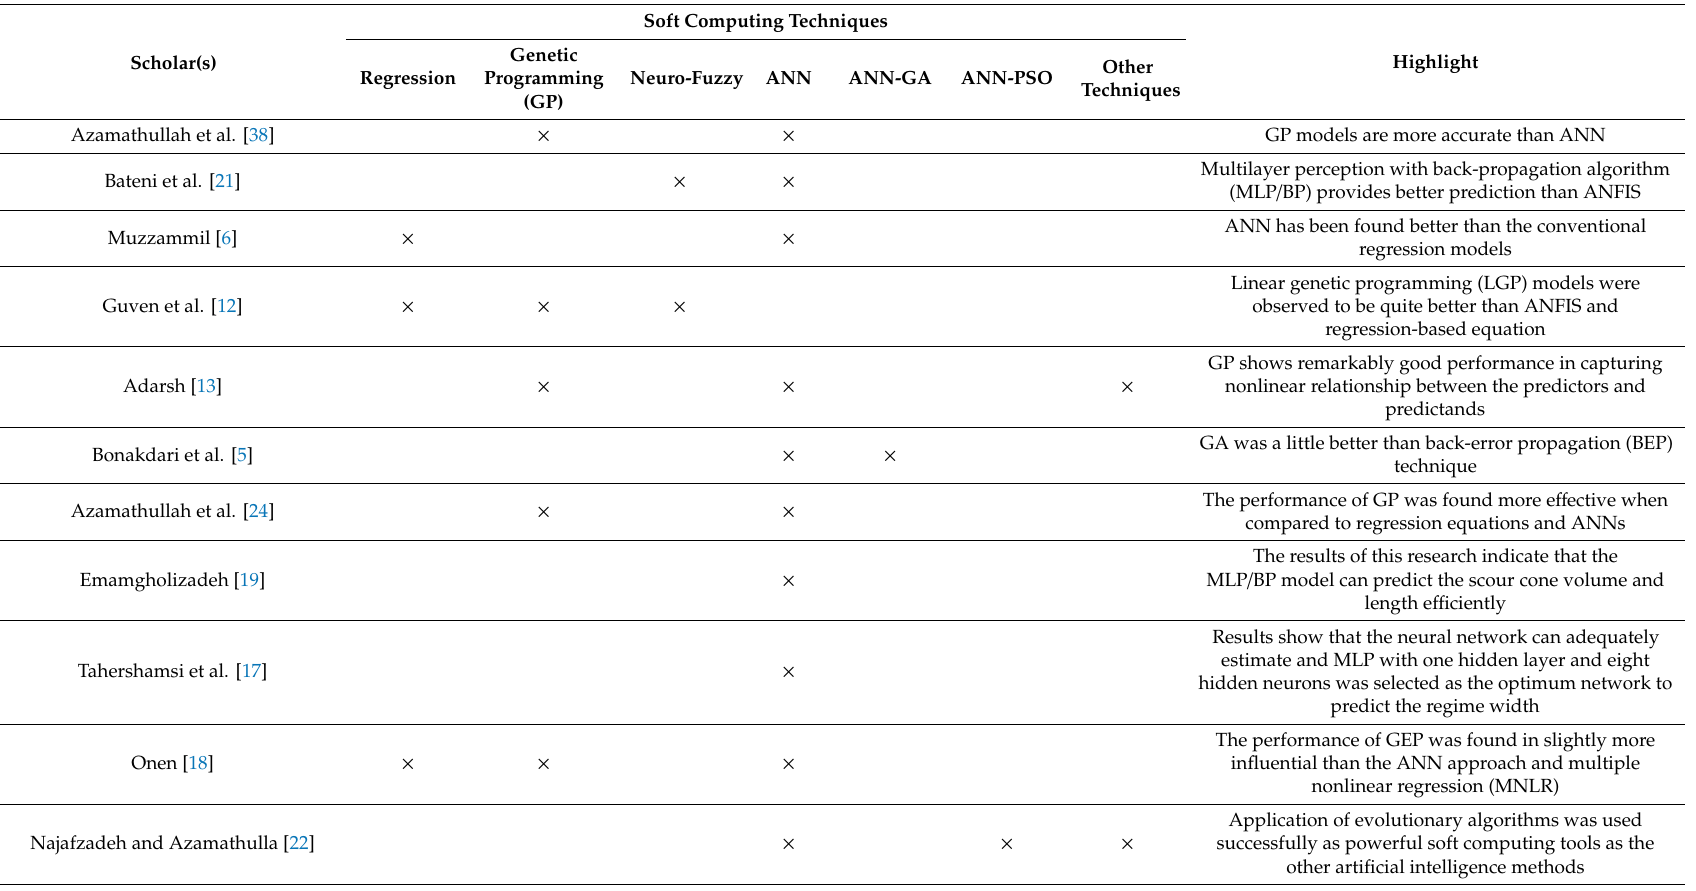
Table 1. Review of application of soft computing techniques in hydraulic structures